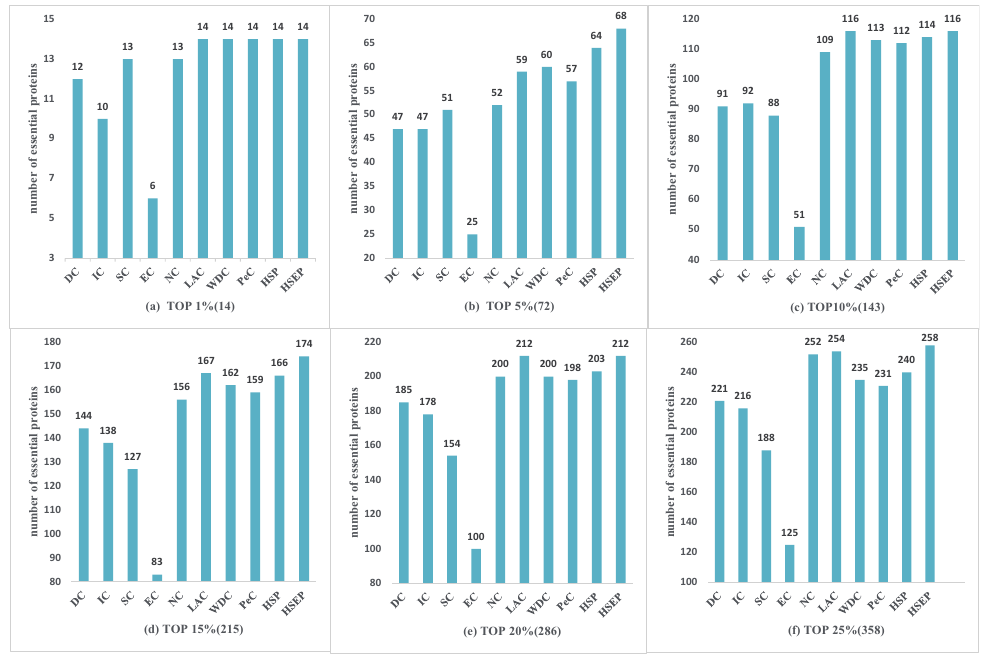
Figure 4. Comparison of HSEP with other essential protein discovery methods on Gavin data. ( f ) TOP 25%